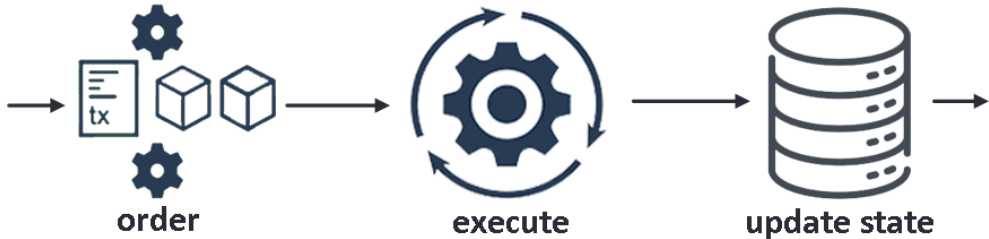
Figure 3. Traditional architecture for building